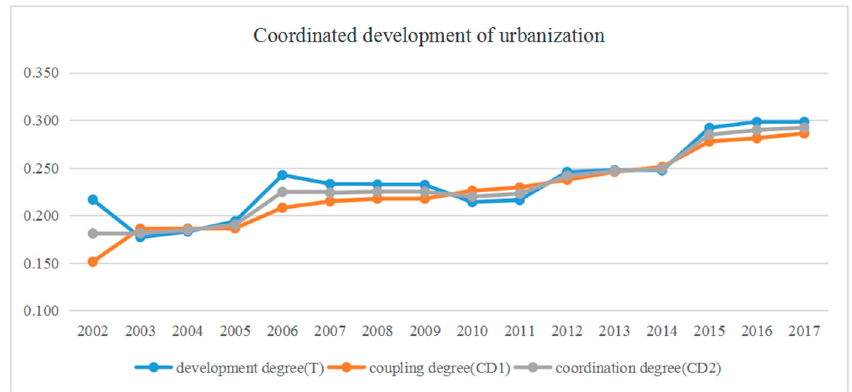
Figure 4. Dynamic coordination degree of urbanization in Nanchang from 2002 to 2017.